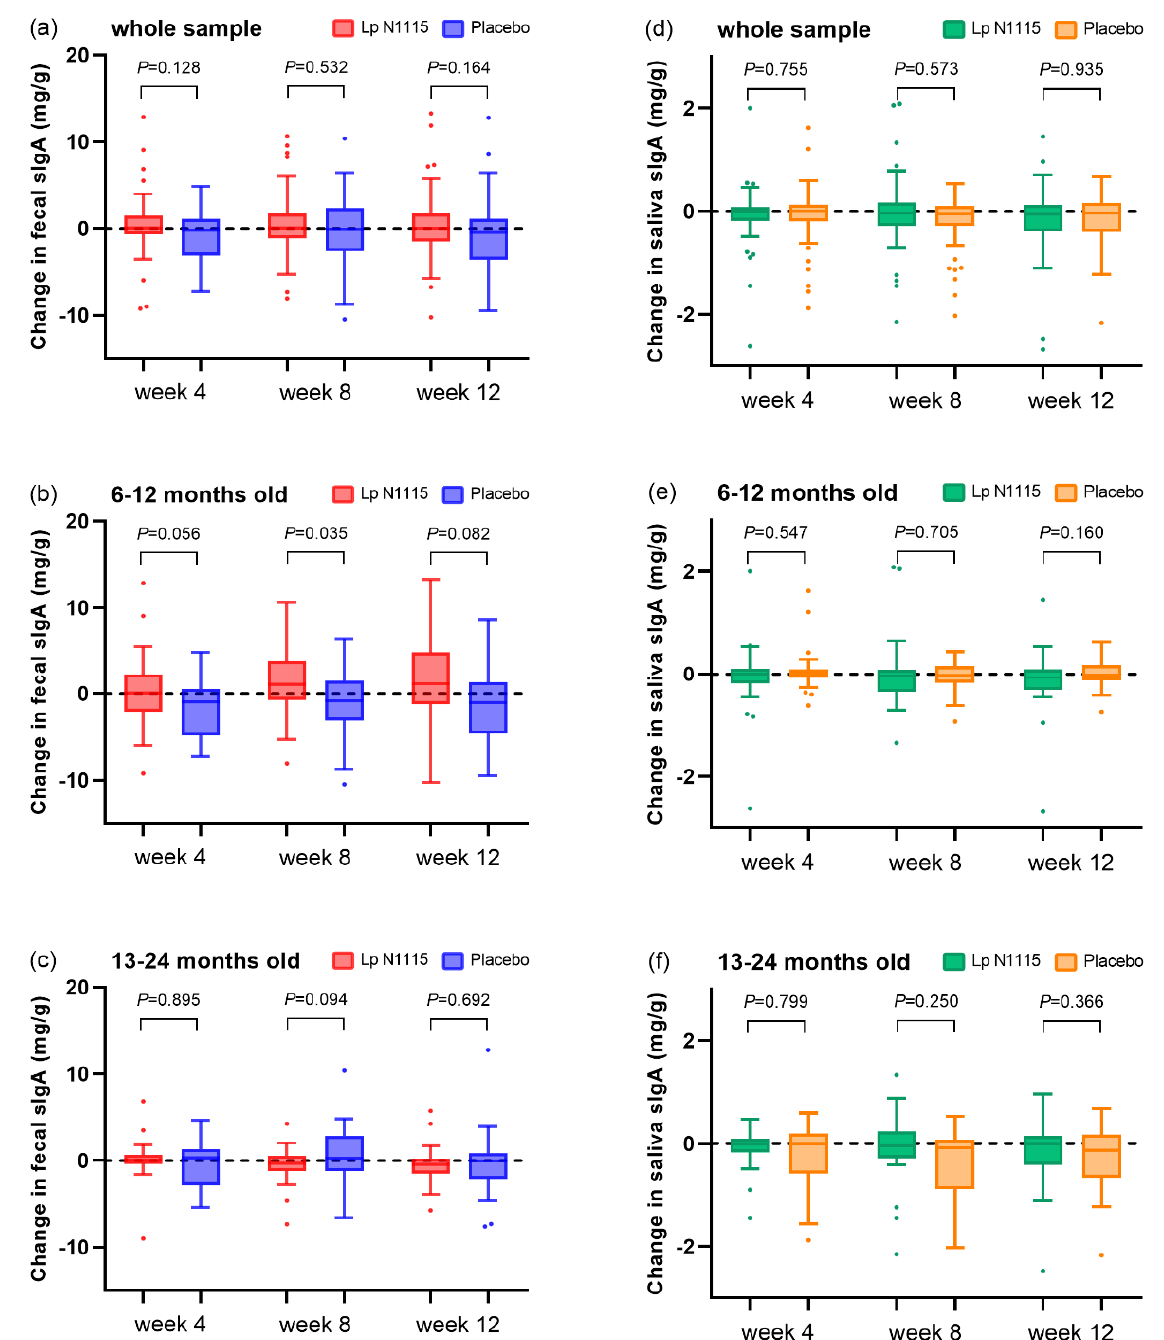
Figure 4. Changes in sIgA in feces and saliva compared with baseline. ( a ) fecal sIgA changes of all participants; ( b ) fecal sIgA changes of 6–12-month-old sub-group; ( c ) fecal sIgA changes of 13–24-month-old subgroup; ( d ) saliva sIgA changes of all participants; ( e ) saliva sIgA changes of 6–12-month-old sub-group; ( f ) saliva sIgA changes of 13–24-month-old subgroup. Analysis of salivary sIgA levels revealed that in the all participants and the 13–24-month- old subgroups only, sIgA in the control group was significantly decreased from baseline at the 8th week (Figure 4d–f, all participants: p = 0.045; 13–24-month-old subgroup: p = 0.028). The change in salivary sIgA in the experimental group relative to baseline was not signifi-